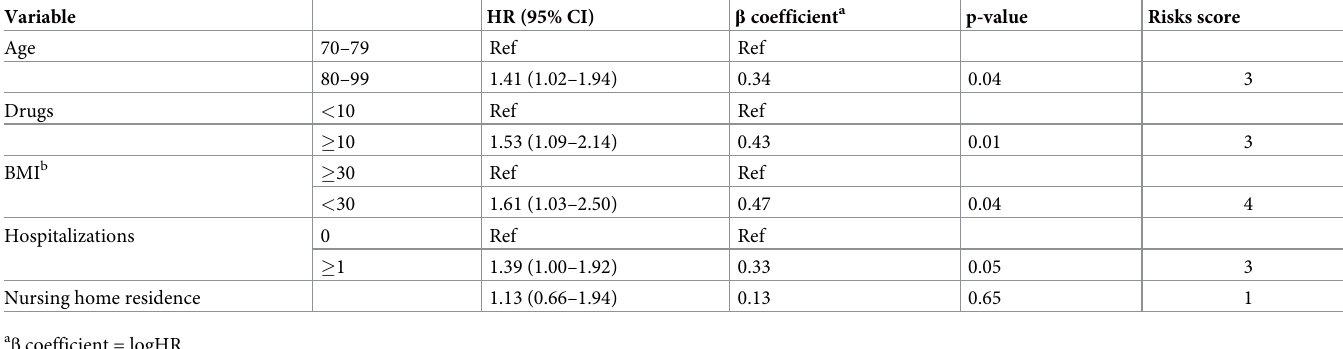
Table 4. 1-year mortality predictors retained in the simplified model and associated risk score.